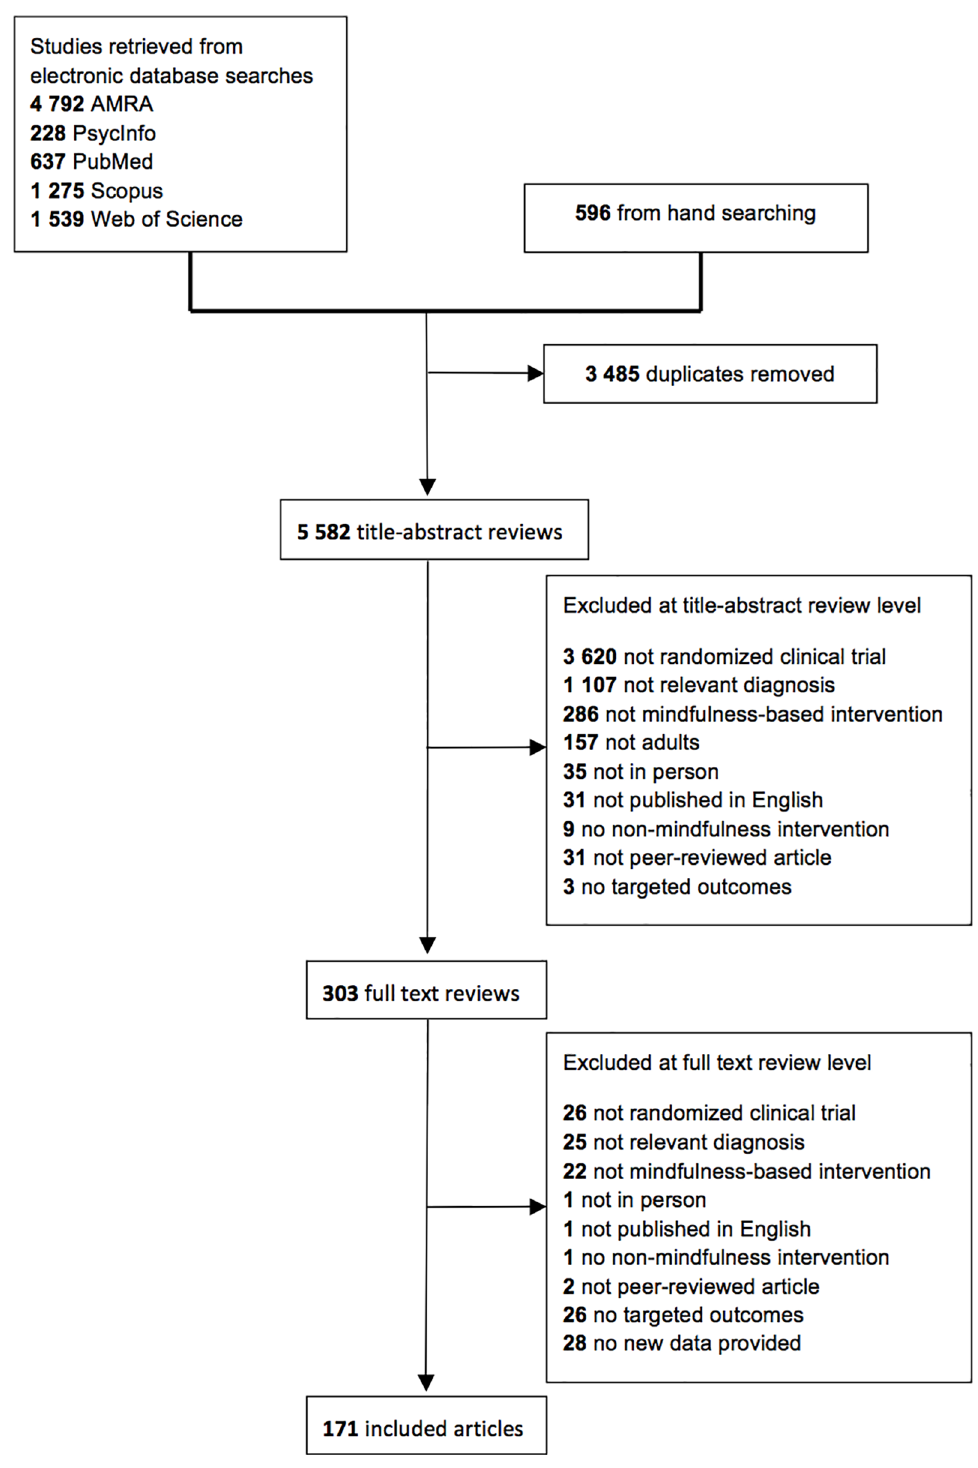
Fig 1. PRISMA flow diagram.